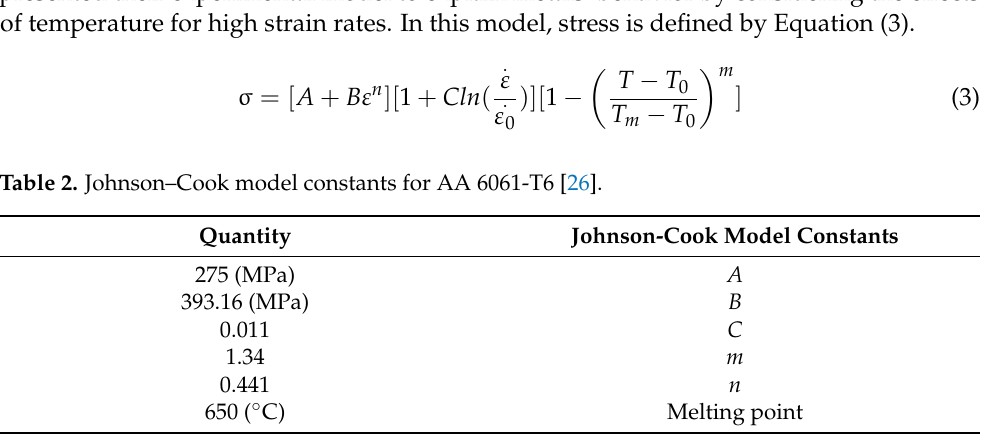
Table 2. Johnson–Cook model constants for AA 6061-T6 [26].